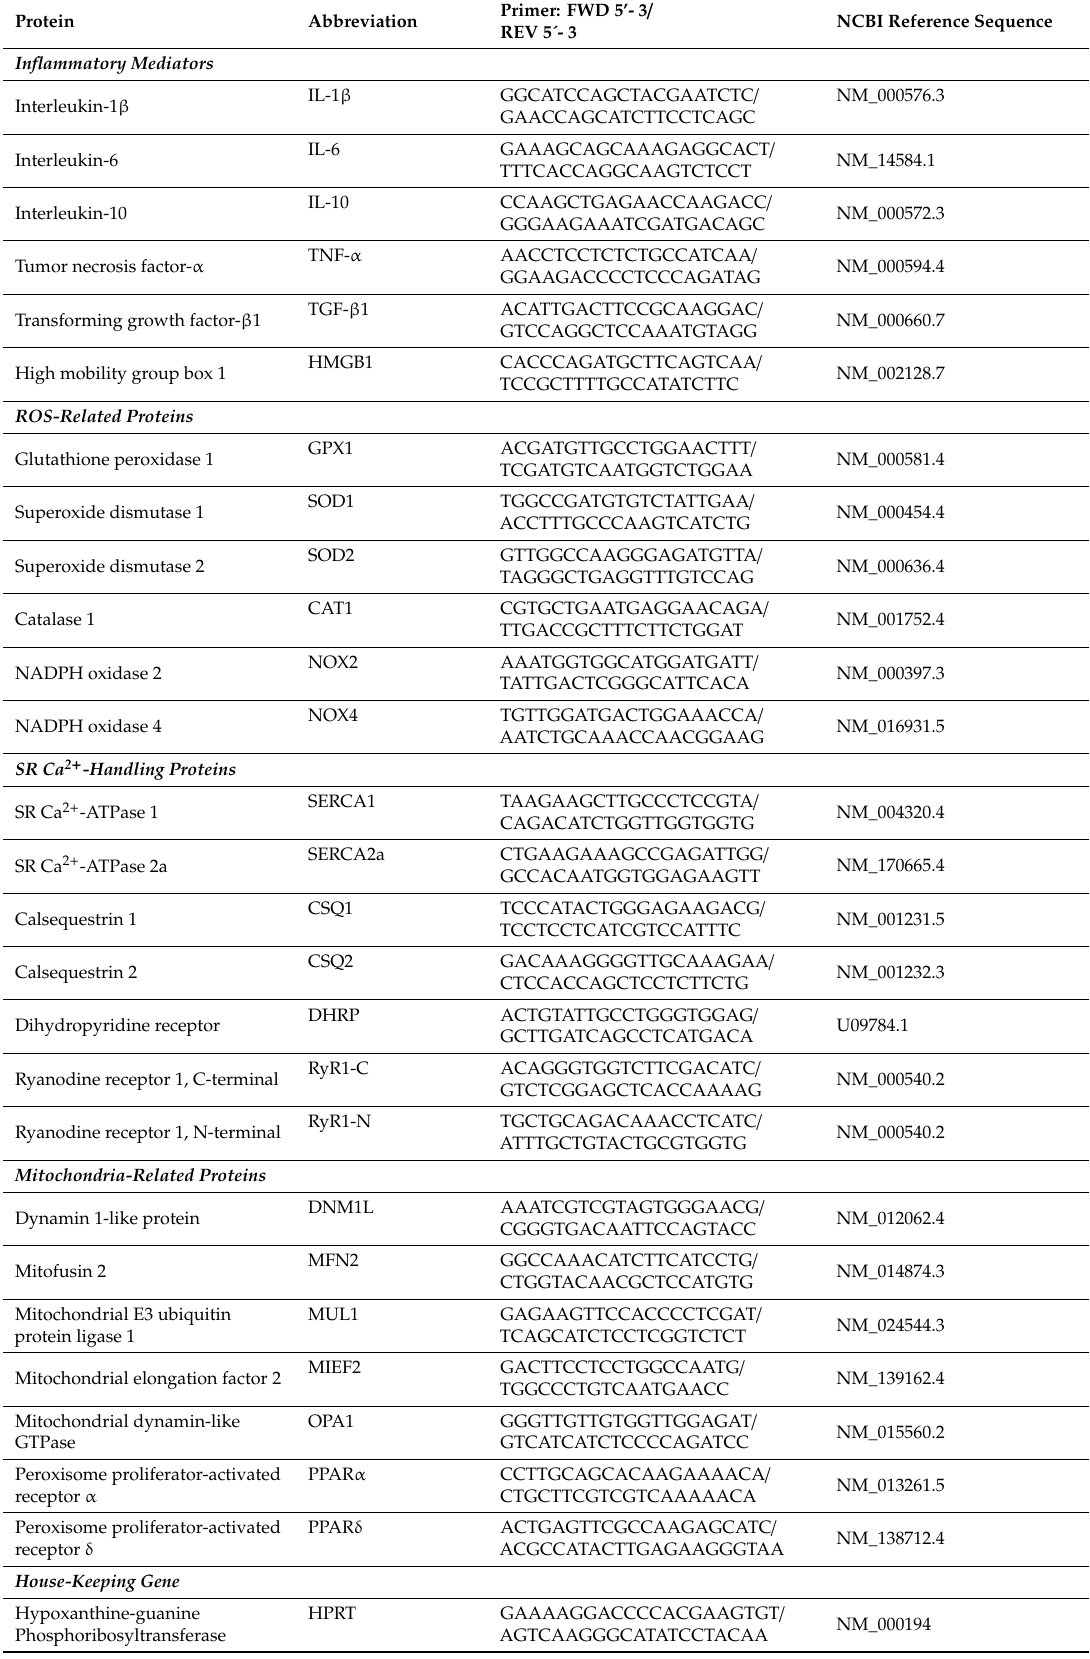
Table 2. Primers used in quantitative real-time PCR